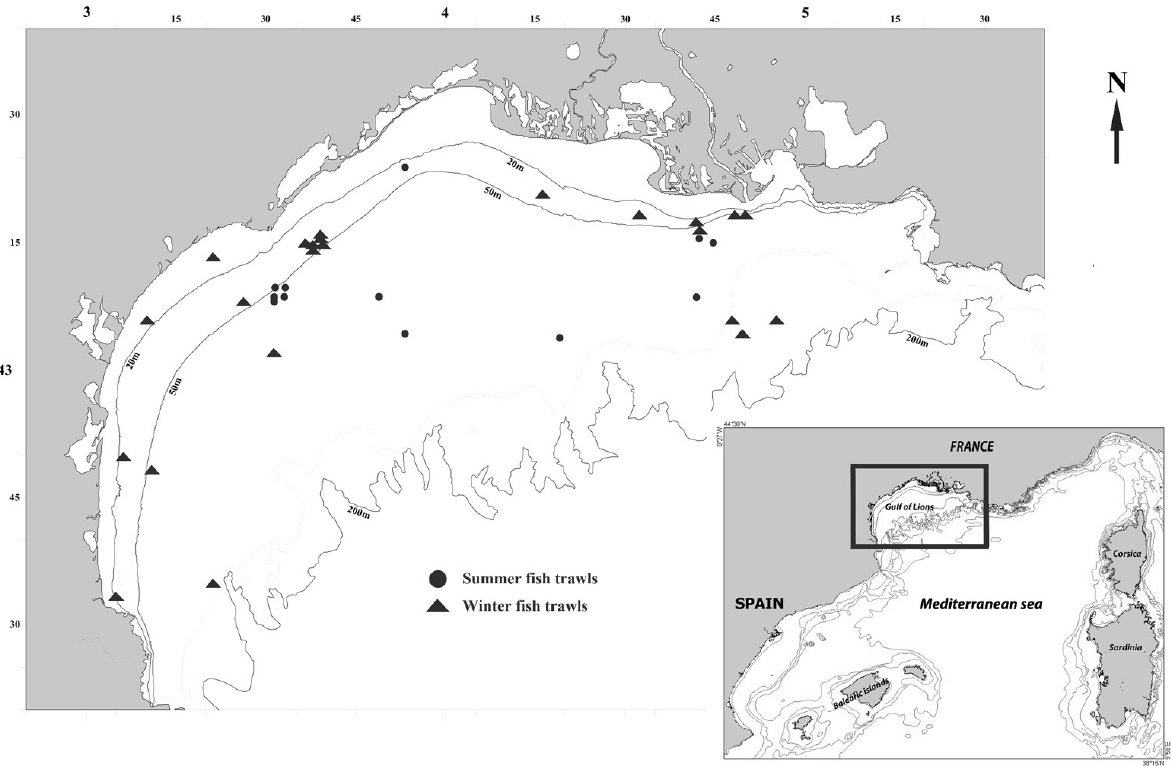
Fig. 1. – Study area (Gulf of Lions, NW Mediterranean), indicating fish and plankton sampling